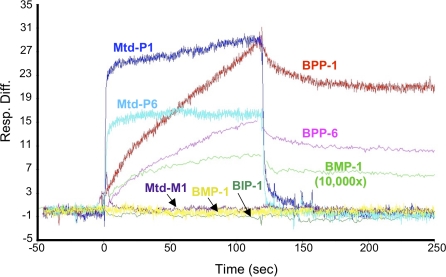
Affinity of Mtd and Avidity of PhageThe SPR sensorgrams showing association of Mtd-P1 (blue), Mtd-P6 (cyan), and Mtd-M1 (purple) and of phage BPP-1 (red), BPP-6 (pink), BIP-1 (thin green), BMP-1 (yellow), and BMP-1 10,000× (thick green) with biotinylated Prn-E immobilized on a streptavidin chip. Curves were chosen for display and represent one of six (or five in the case of BMP-1 10,000×) different concentrations.